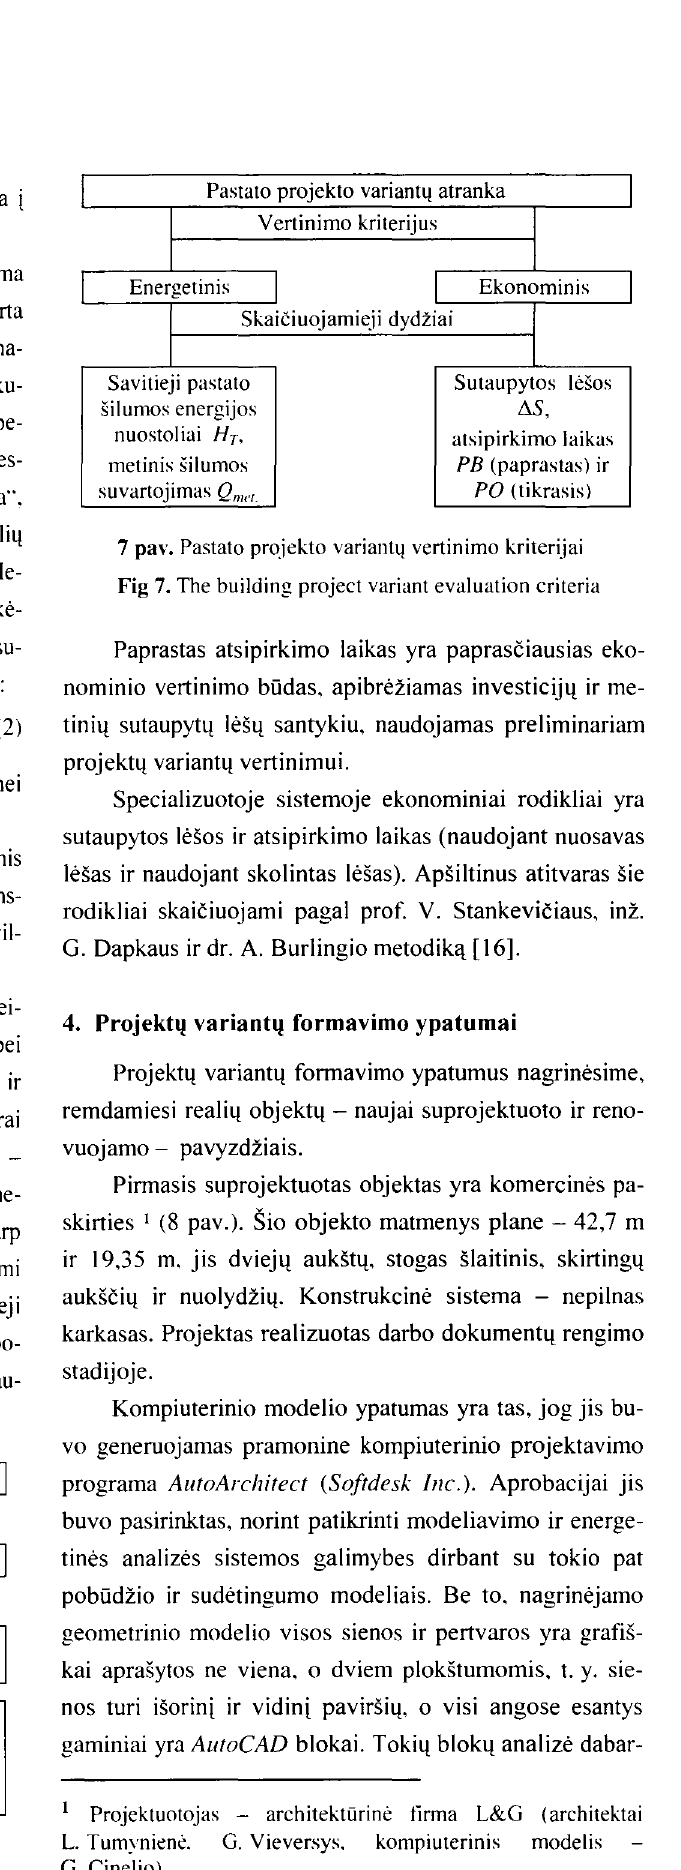
Fig 6. The building project variant solutions